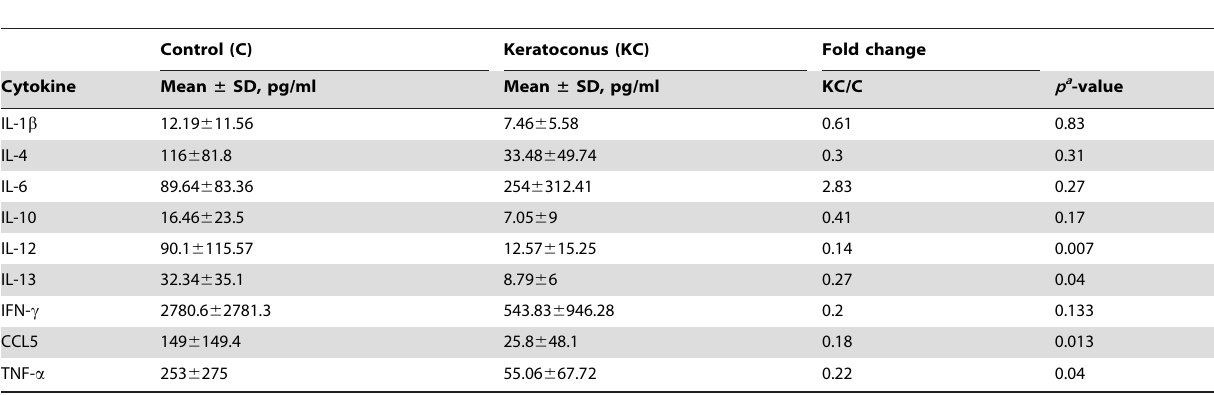
Table 3. Tear-fluid cytokine concentrations in severe (K . 52D) keratoconus and control subjects.